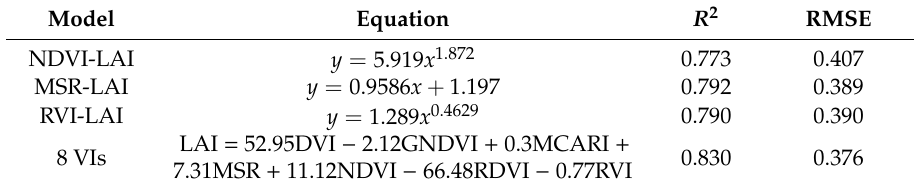
Table 4. The optimal inverse model and accuracy check of peanut LAI with each vegetation index construction.